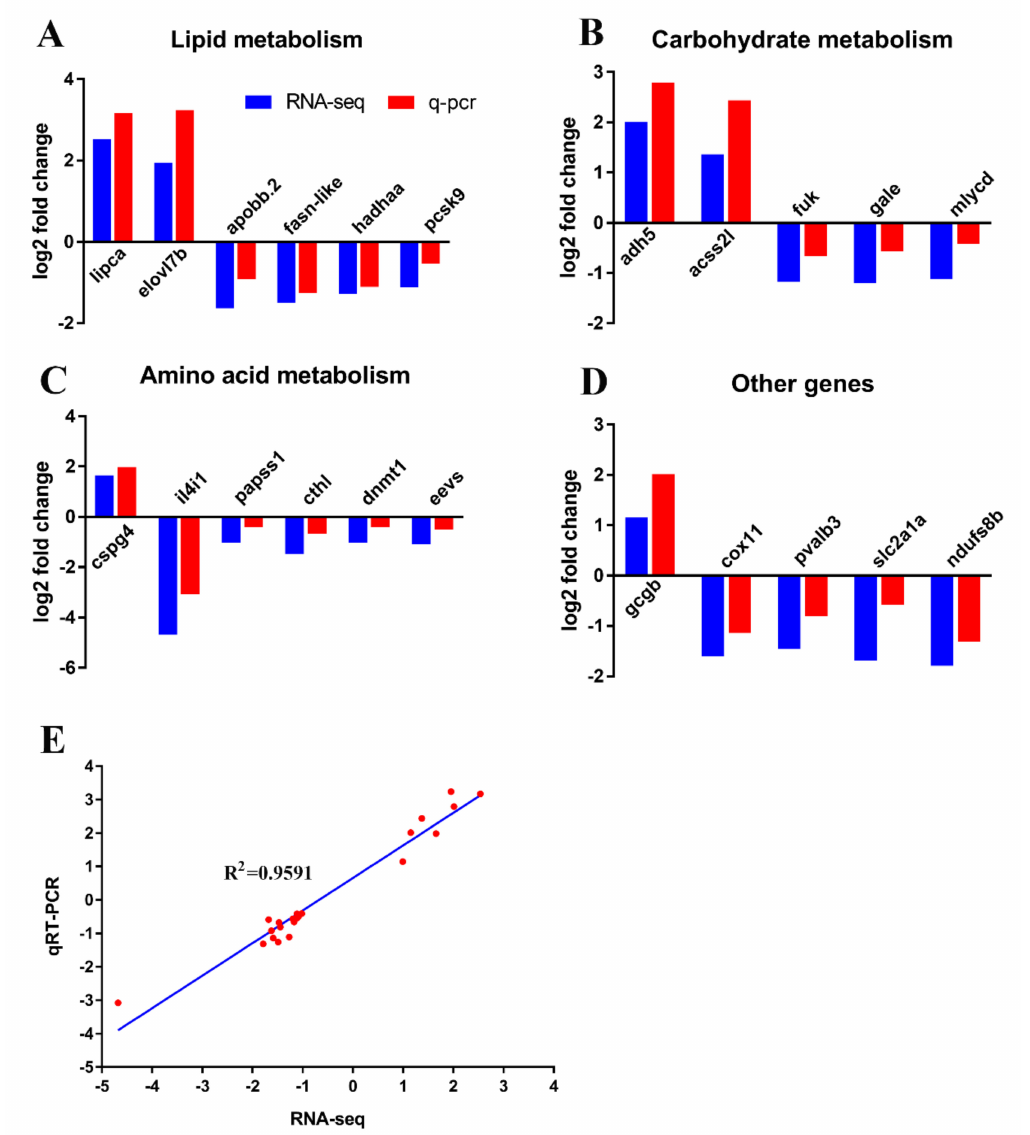
Figure 7. Validation of RNA-seq data using qPCR. ( A–D ) The validation of the expression levels of di ff erentially expressed genes by qRT-PCR analysis in the categories of lipid metabolism ( A ) carbohydrate metabolism, ( B ) amino acid metabolism, ( C ) and other DEGs ( D ). ( E ) Correlation between qRT-PCR and RNA-seq results for select DEGs. The log2 (fold change) values derived from the RNA-seq analysis of DEGs are compared with those obtained by qRT-PCR determined by 2 − ∆∆ C T . The reference line indicates the expected linear